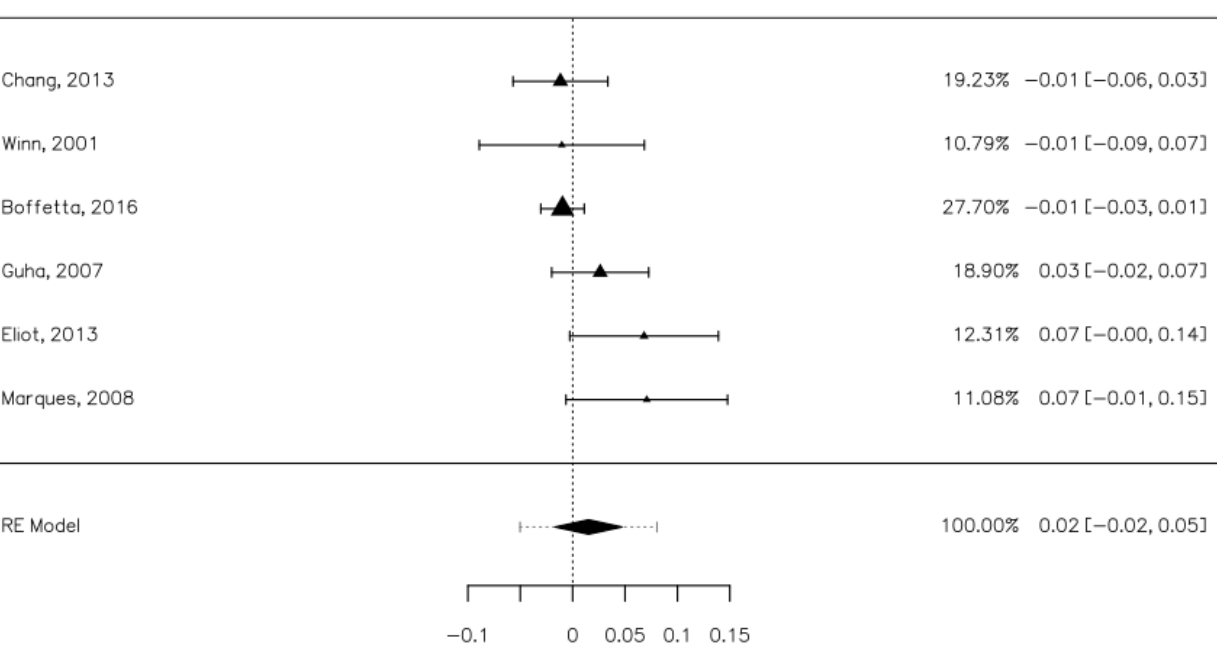
Figure 5. Forrest plot. The risk of pharyngeal cancer associated with mouthwash use.